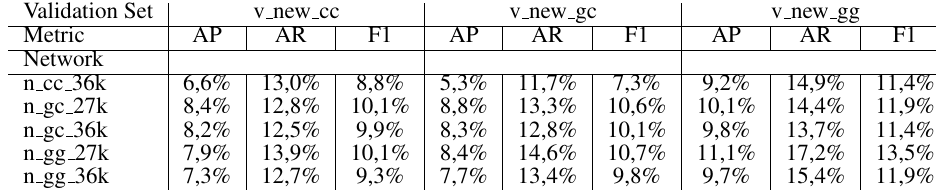
Table 3. Validation Results on the images trained on